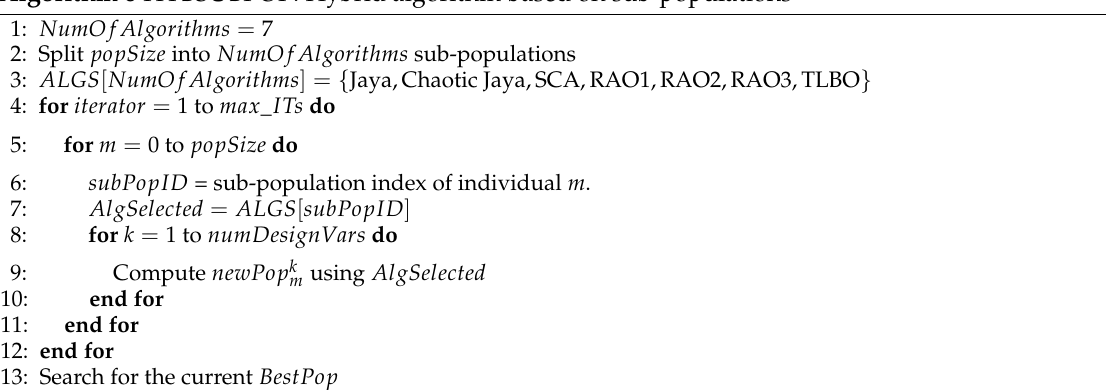
Algorithm 8 HYBSUBPOP: Hybrid algorithm based on sub-populations